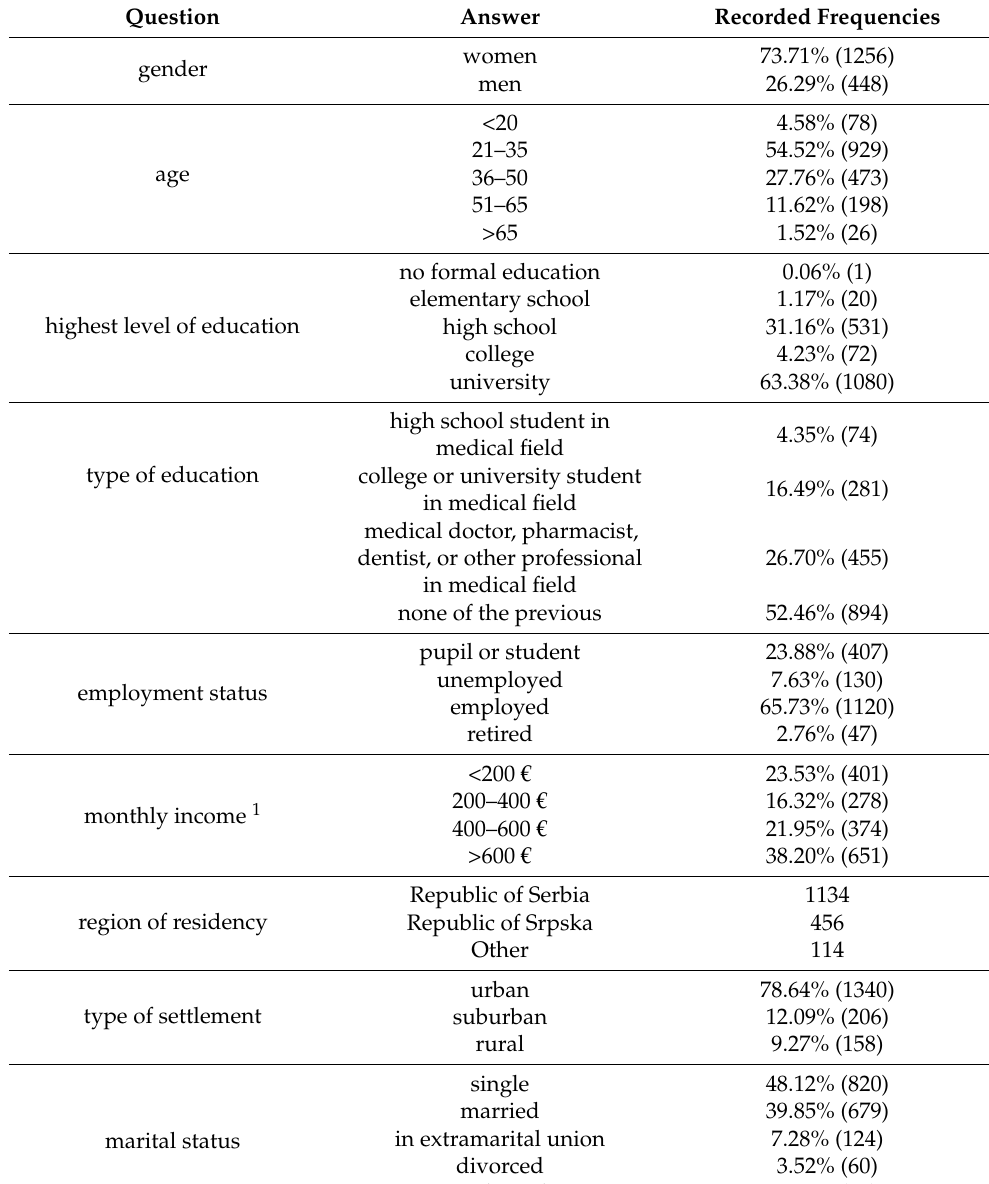
Table 1. Socio-demographic data of